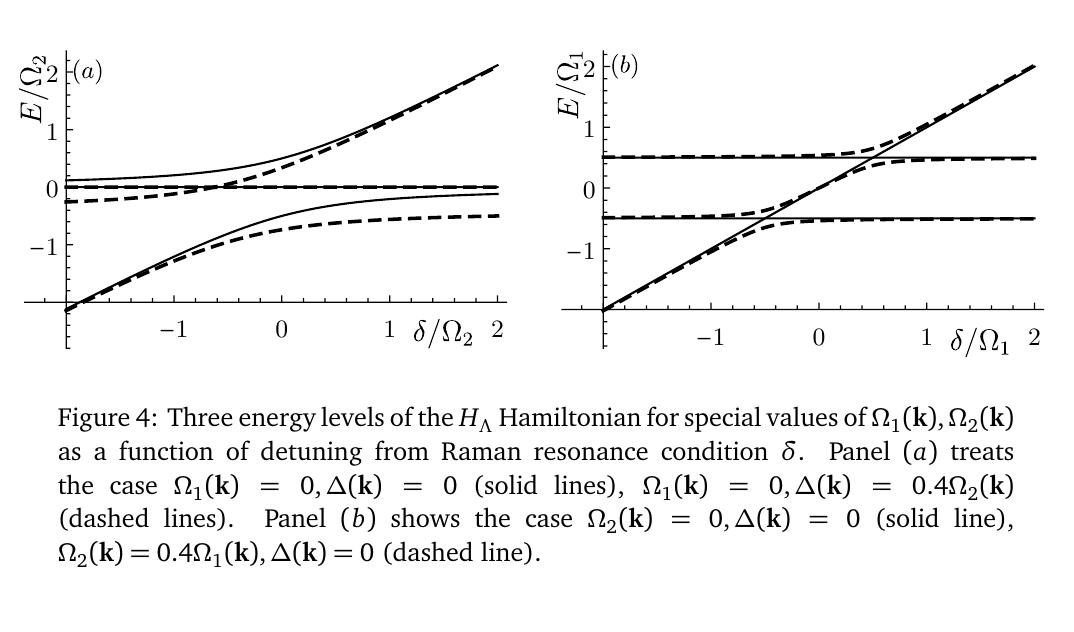
Figure 4: Three energy levels of the H Λ Hamiltonian for special values of Ω as a function of detuning from Raman resonance condition δ . Panel ( a ) treats ( k ) = 0, ∆ ( k ) = 0 (solid lines), Ω the case Ω 1 (dashed